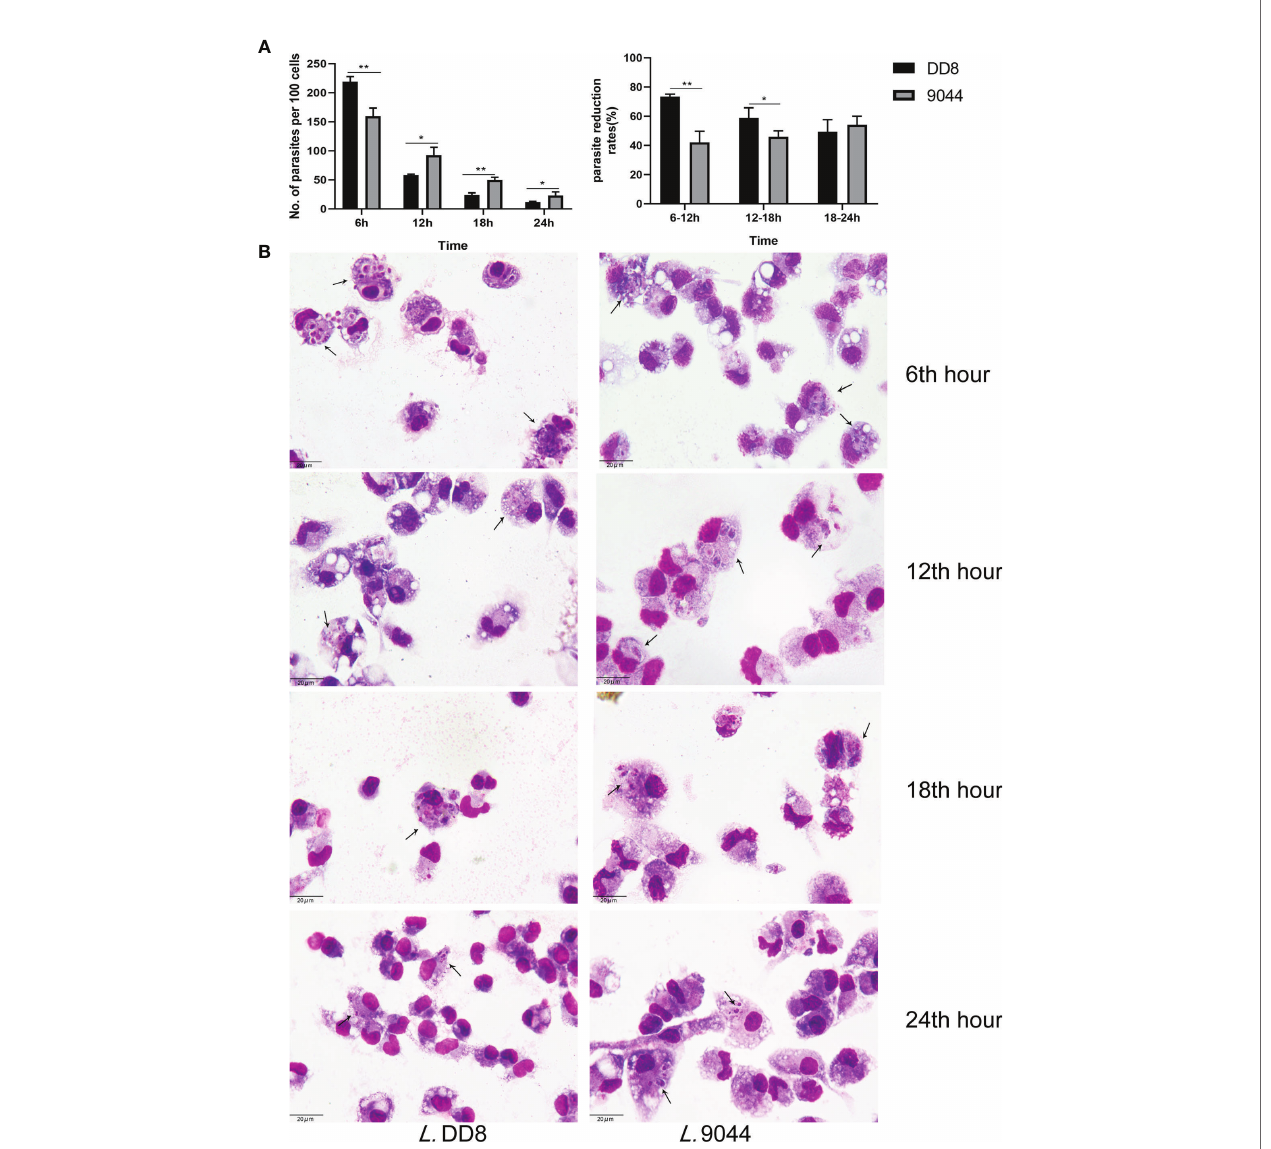
FIGURE 1 | Parasite burdens of L . DD8 and L . 9044. Peritoneal macrophages were respectively infected with promastigotes ( L . DD8 and L . 9044). The cells were stained by Wright ’ s staining for the evaluation of parasite burdens at 6, 12, 18, and 24 h. (A) Parasites were counted per 100 cells under 1000 power magni fi cation. The number of parasites inside cells at each time point were presented and the ratio of burden reduction was calculated. (B) The cells were stained by Wright ’ s staining at 6, 12, 18, and 24 h, and parasites were marked using arrows. Statistical analyses were performed by IBM SPSS Statistics 22 with Student ’ s t -test, and the signi fi cant difference was designed as asterisks (* P <0.05, ** P